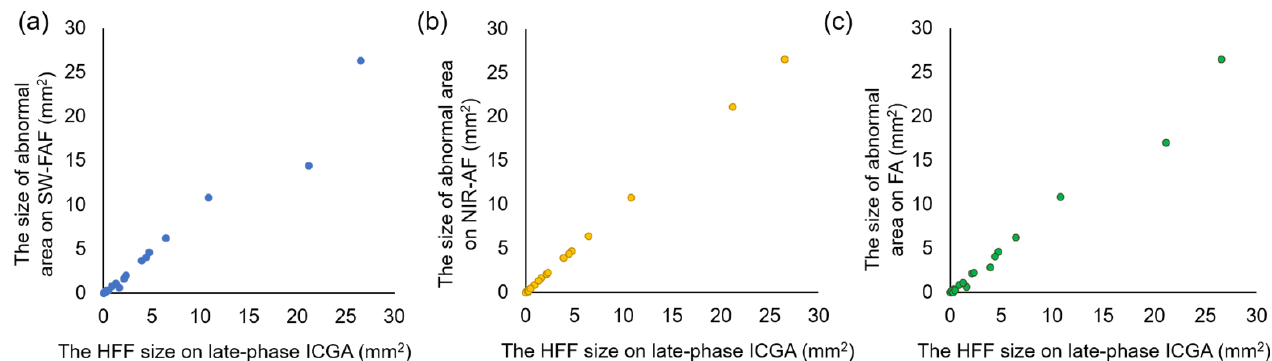
Figure 1. ( a ) Scatter plot of the HFF size of late-phase ICGA (mm 2 ) and the size of abnormal area on SW-FAF (mm 2 ), ( b ) the scatter plot of the HFF size of late-phase ICGA (mm 2 ) and the size of abnormal area on NIR-AF (mm 2 ), and ( c ) the scatter plot of the HFF size of late-phase ICGA (mm 2 ) and the size of abnormal area on FA (mm 2